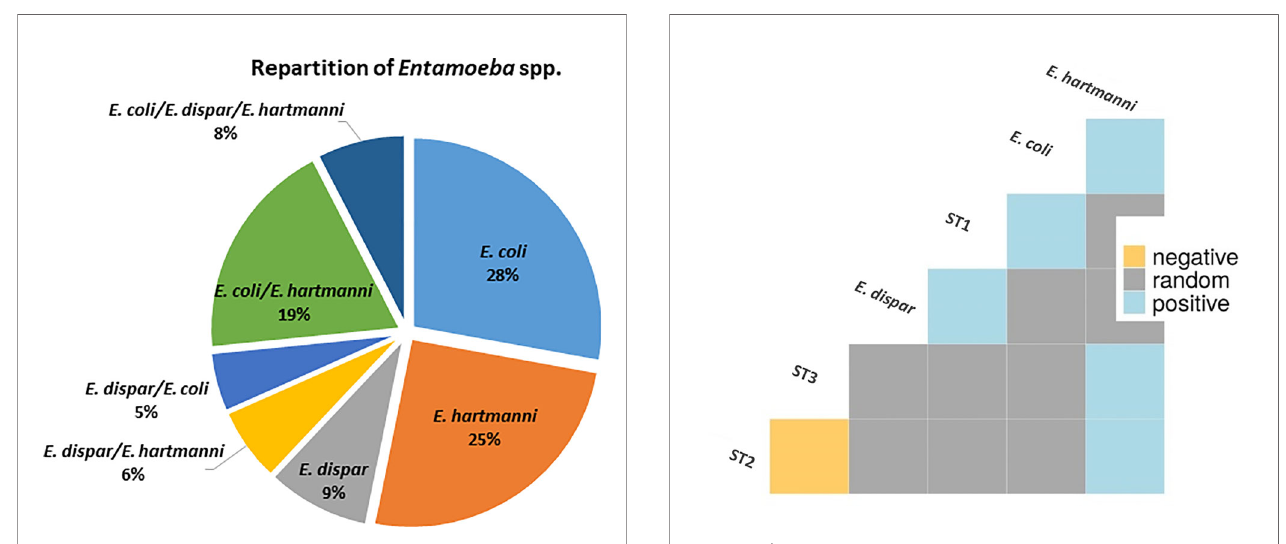
FIGURE 2 | Distribution of identi fi ed Entamoeba species detected in colonized Cameroonian individuals.